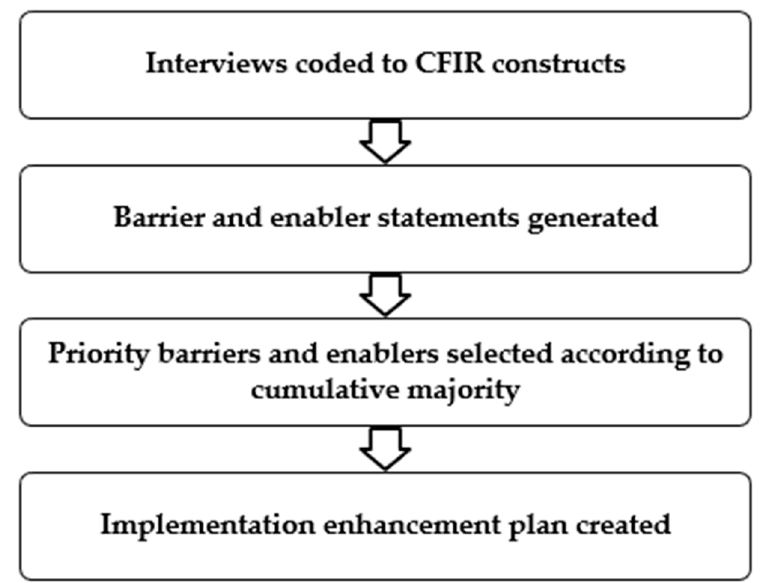
Figure 1. Data coding and barrier/enabler mapping